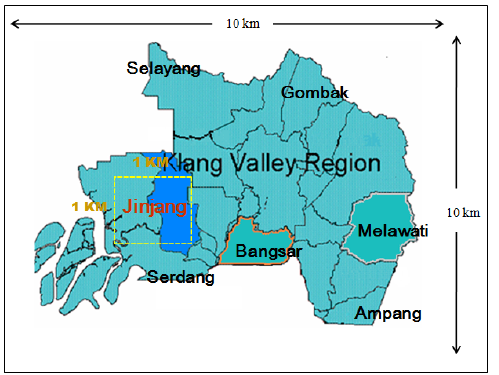
Figure 3. Location of study area at Klang Valley Region